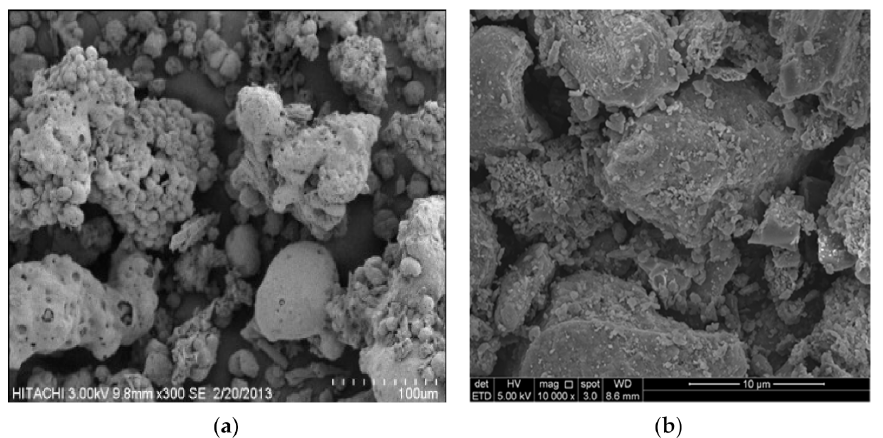
Figure 3. Microstructure of POFA ( a ) before [11,31] and ( b ) after grinding at 10 k